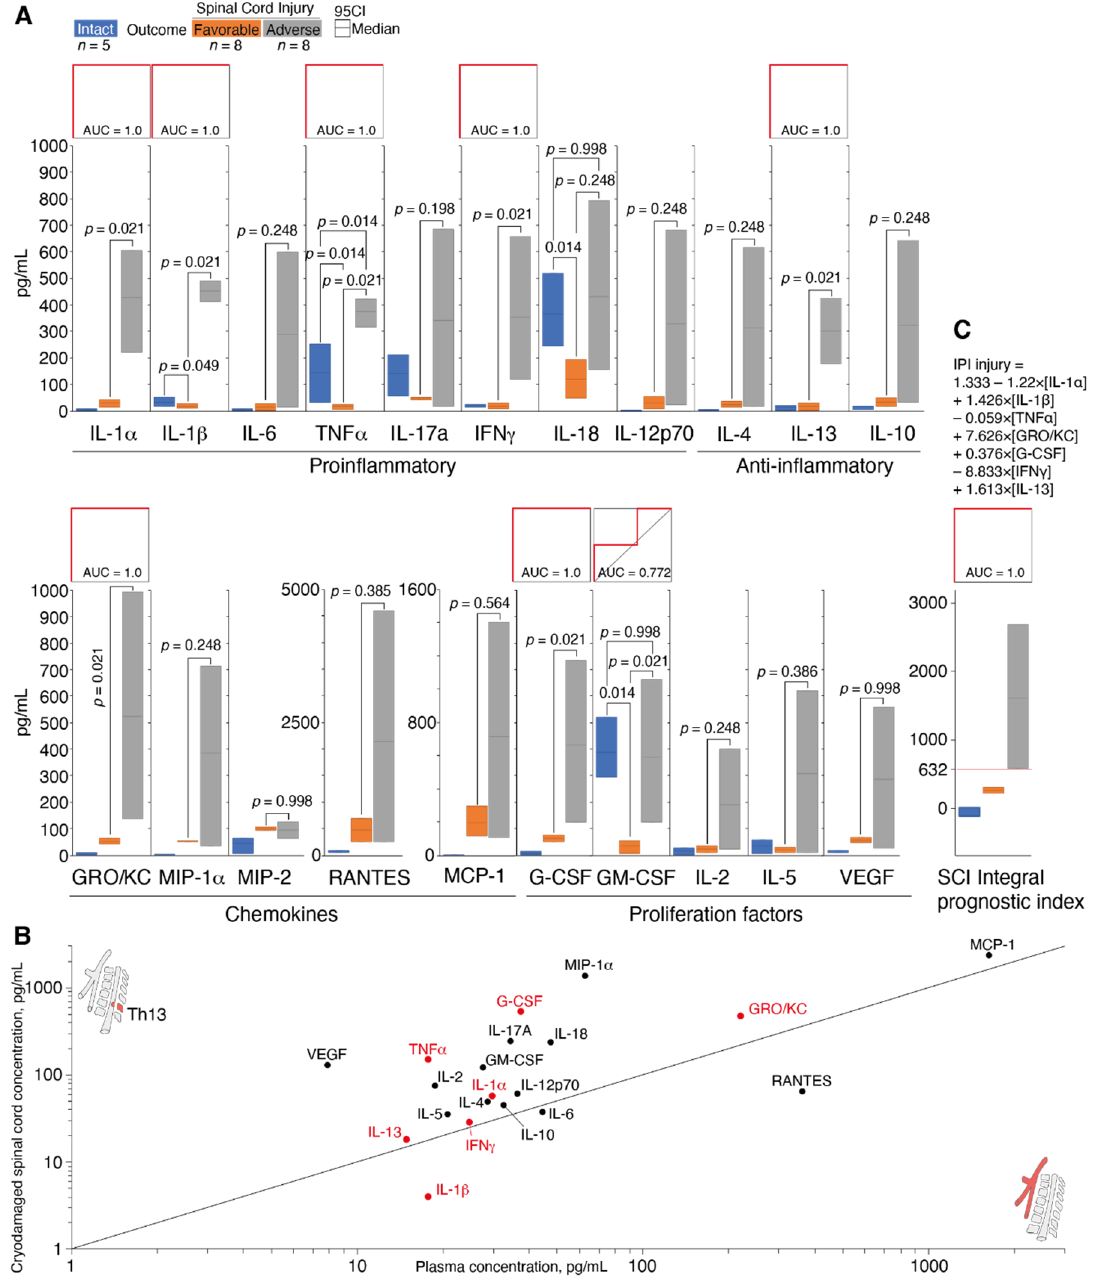
Figure 4. Levels of plasma cytokines and chemokines in the animals with spinal cord cryoinjury in the groups with favorable and adverse outcomes. ( A ) The 95% confidence intervals (CI) for the levels of plasma cytokines and chemokines and their predictive value based on ROC curves. ( B ) Correlation plot of cytokines/chemokines concentration in plasma and injured spinal cord. Factors with ROC = 1 are shown in red. ( C ) The 95% confidence intervals for the integral prognostic index of injury (IPI injury) and its predictive value based on the ROC curve. Bars represent standard 95% CI in groups with favorable (orange) and adverse outcomes (grey) in comparison with intact animals (blue), the p values according to the Mann–Whitney test are indicated. Granulocyte colony-stimulating factor (G-CSF), vascular endothelial growth factor (VEGF), granulocyte-macrophage colony-stimulating factor (GM-CSF), keratinocyte chemoattractant (KC), tumor necrosis factor (TNF), interferon gamma (IFN γ ), Regulated upon Activation, Normal T Cell Expressed and Presumably Secreted (RANTES/CCL5), monocyte chemoattractant protein 1 (MCP-1/CCL2) and macrophage inflammatory proteins (MIP)—MIP-1a and MIP2.